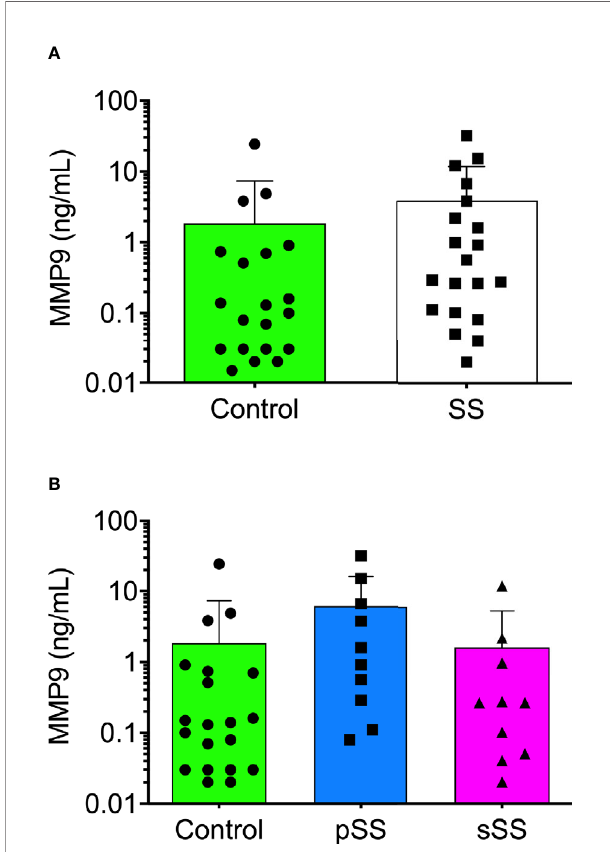
FIGURE 4 | Detection of human MMP9 in the saliva from Sjögren ’ s syndrome individuals. The MMP9 concentration was measured in all saliva samples [ (A) ; Mann – Whitney test] and between SS groups [ (B) ; Kruskal – Wallis test] with the Human MMP9 DuoSet ELISA kit (R&D Systems, USA) according to the manufacturer ’ s instructions.